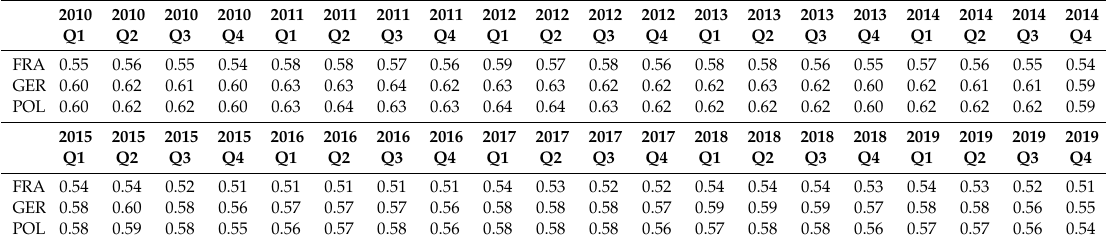
Table 3. Share of imports of intermediate goods in total imports (in %), own work, source: Eurostat. 2010